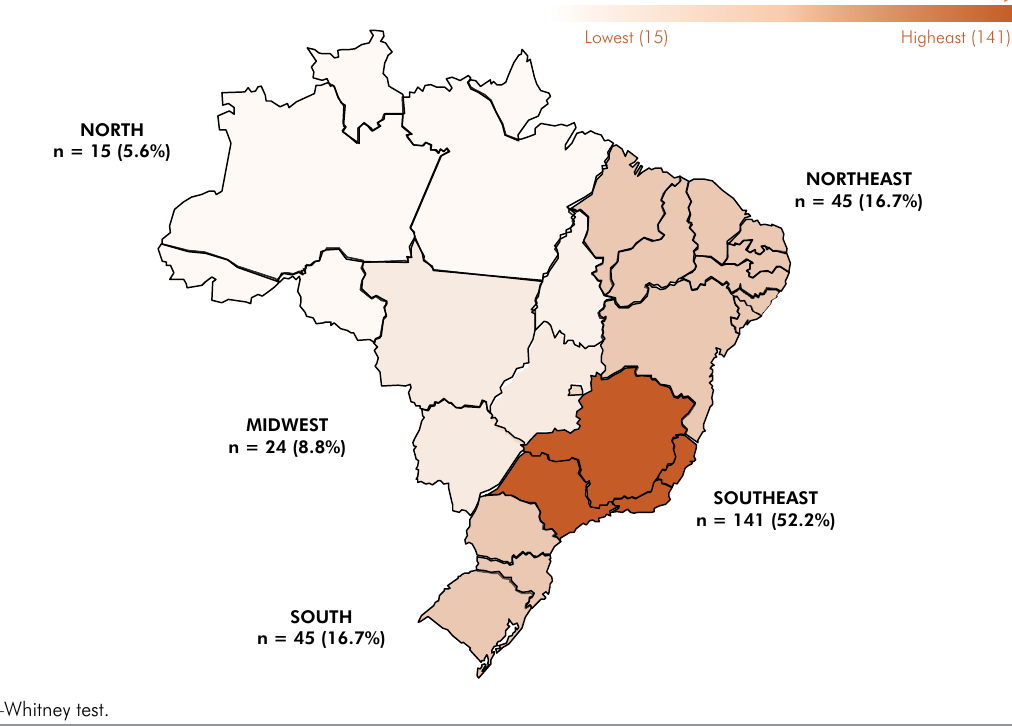
Figure 2. Distribution of sample’s dentists in each region of the country.